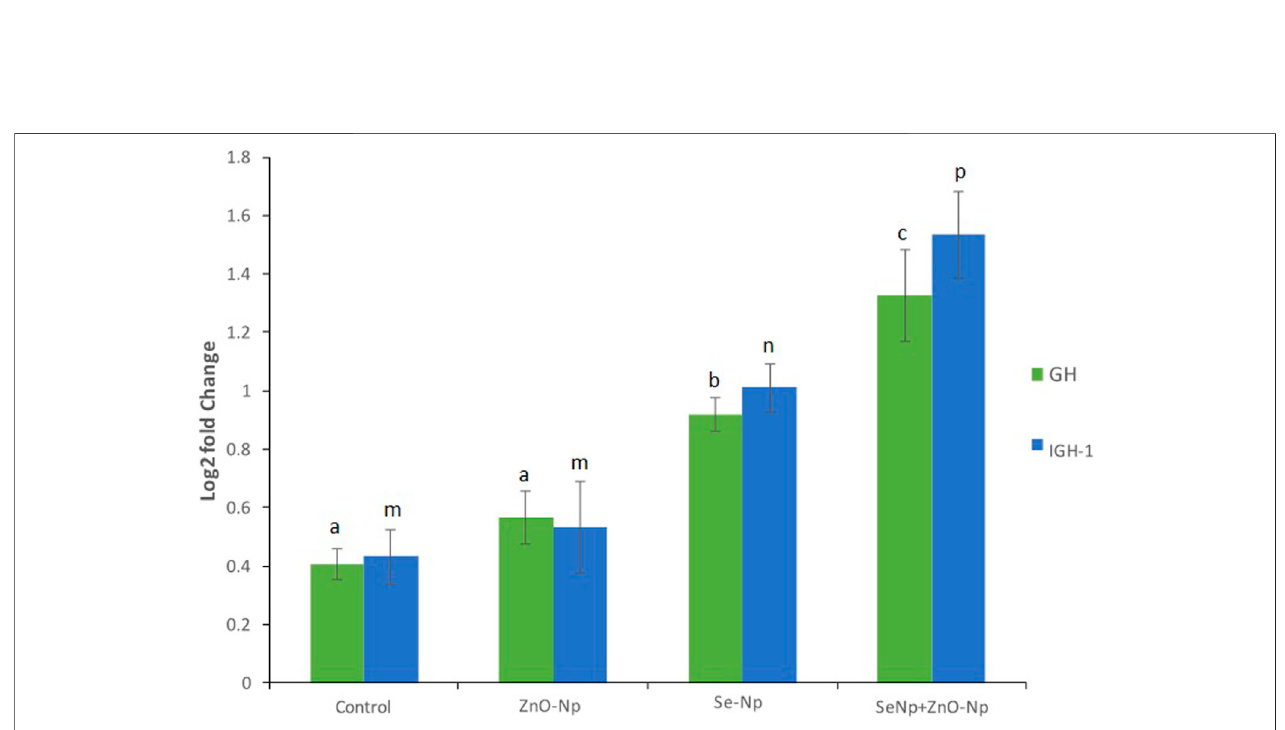
FIGURE 4 | qRT-PCR bar graphs showing the log2 fold change in the growth-related genes growth hormone (GH), and insulin-like growth factor-1 (IGF-1) expression in the different groups, showing signi fi cantly upregulation in the SeNPs + ZnONPs group compared to all groups ( p < 0.001).